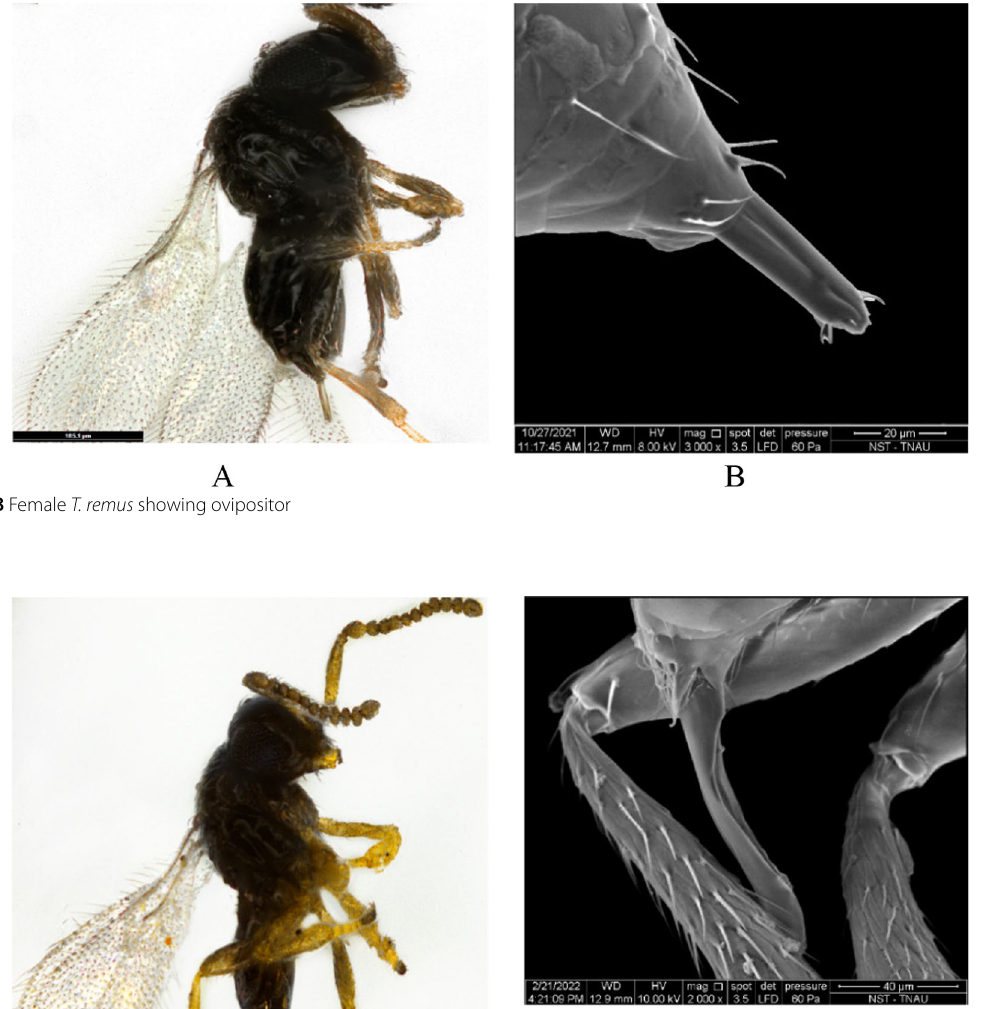
be differentiated based on the development of external organs viz ., blackening of abdominal region (I phase), partial development of head, thoracic and abdomi- nal regions (II phase), complete development of head region showing antennal socket, eye region, thoracic and abdominal regions (III phase), complete develop- ment and blackening of abdominal region showing dis- tinct segments and initiation of tanning (IV phase) and completion of tanning and complete development of abdomen, thorax and wing pads (V phase). On the first day, the pupa is opaque white and later it turns to black colour as described by Oktaviani et al. (2021) on T. remus in FAW eggs which was in conformity with our